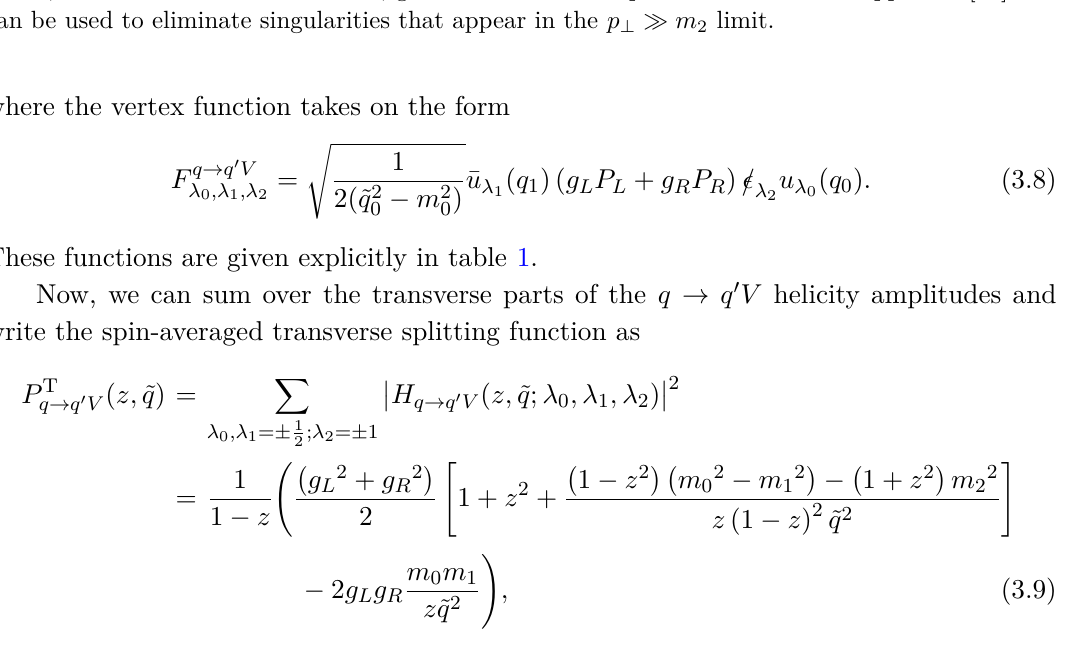
represent the helicity states 2